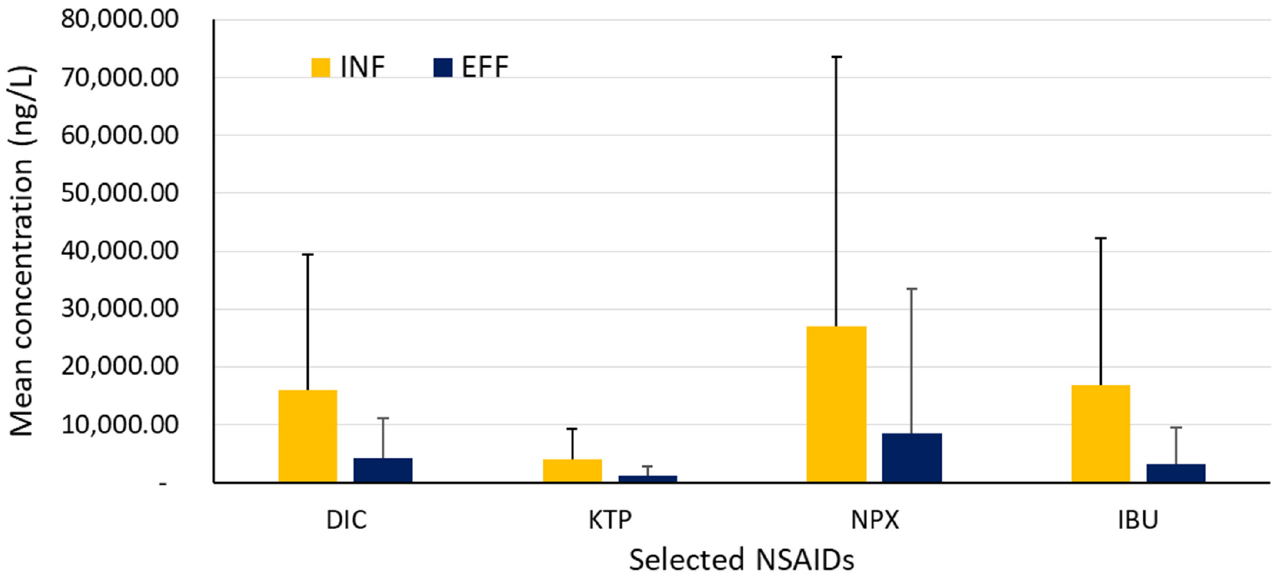
Figure 2. Mean concentration of diclofenac, ketoprofen, naproxen, and ibuprofen in influent and effluent wastewater samples in different countries. All resulted are cited from different sources: